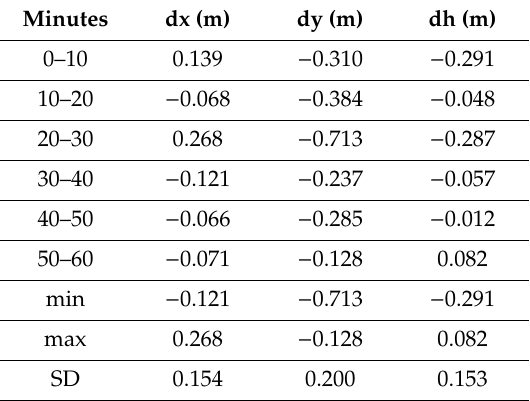
Figure 21. 60 min session positioning results for the third test, baseline OPNT–P30Pro (4 km). Table 11. 10 min sub-session positioning results summary, baseline OPNT–P30Pro (4 km).